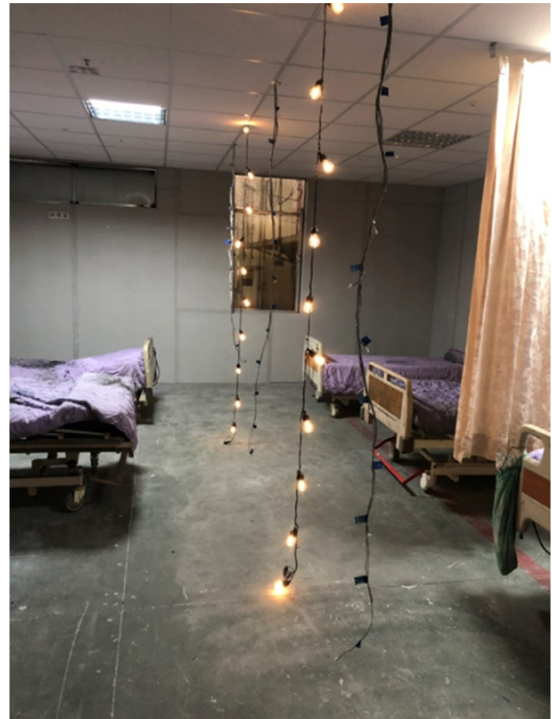
Figure 20. Five-person